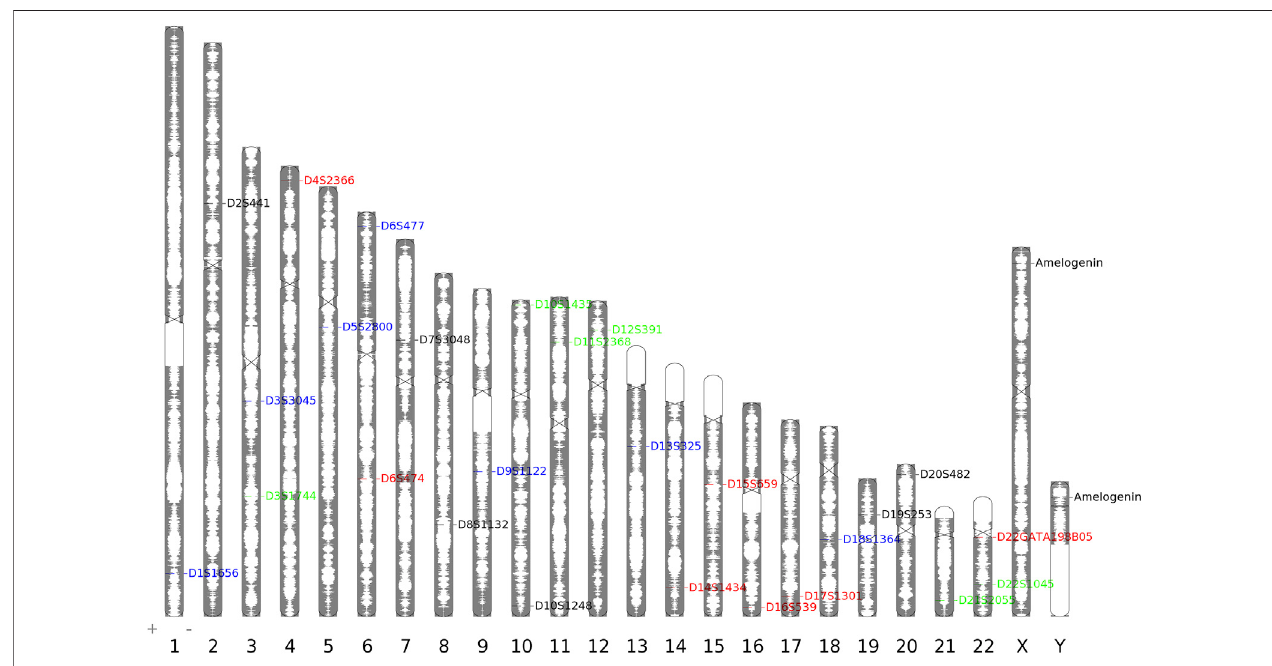
FIGURE 1 | Loci information of 26 autosomal STRs and the amelogenin